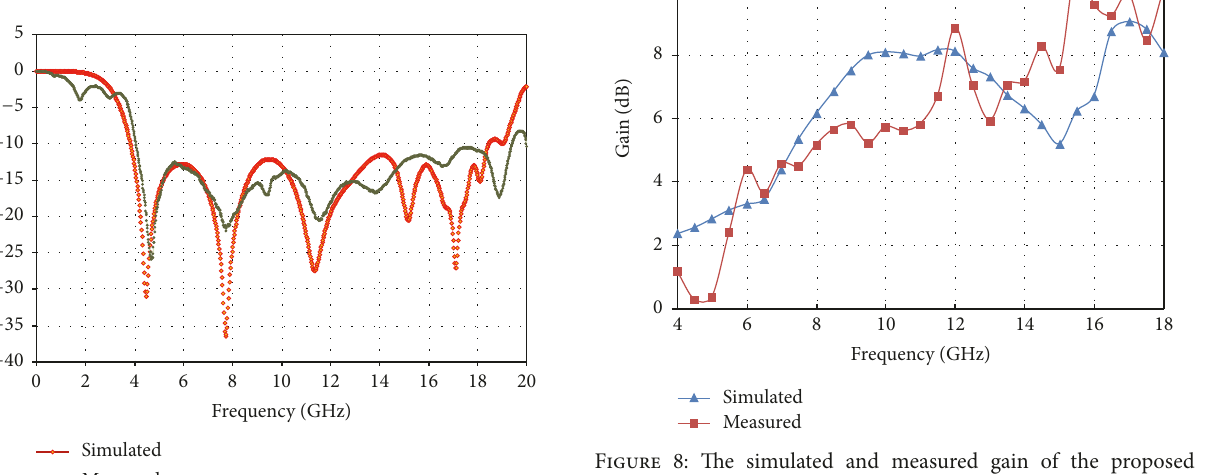
Figure 5: Results of simulation 𝑆 11 with variation in the width of the gap between patches ( 𝐺 are in mm).